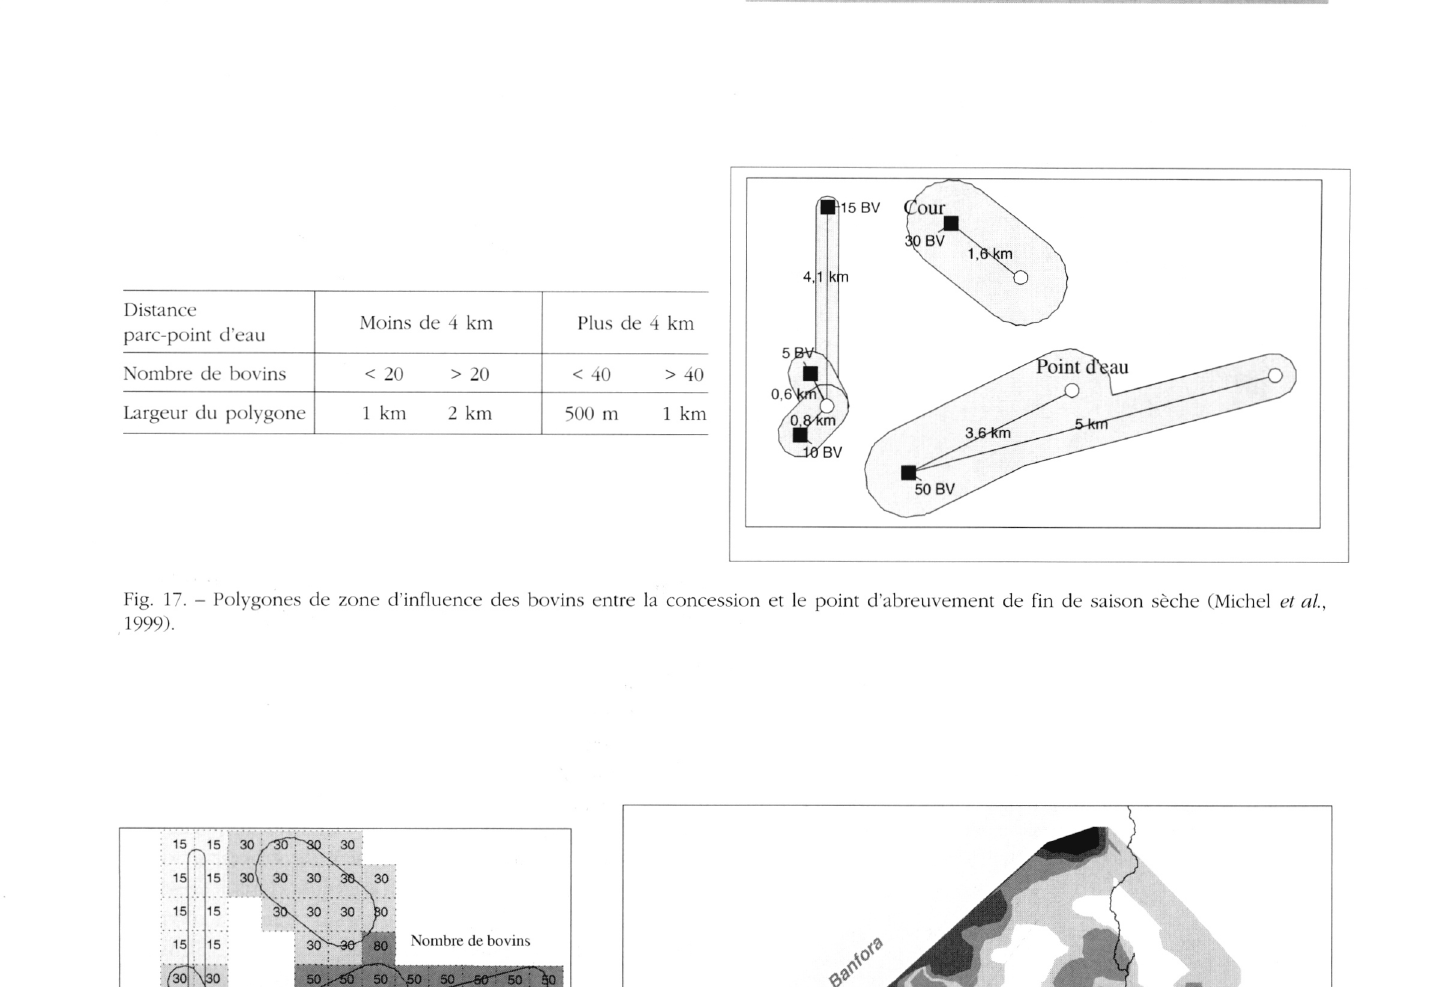
Fig. 18. - Répartition des bovins dans la zone de Sidéradougou. Carte obtenue par projection des polygones sur un maillage géogra­ phique puis lissage par régression locale.